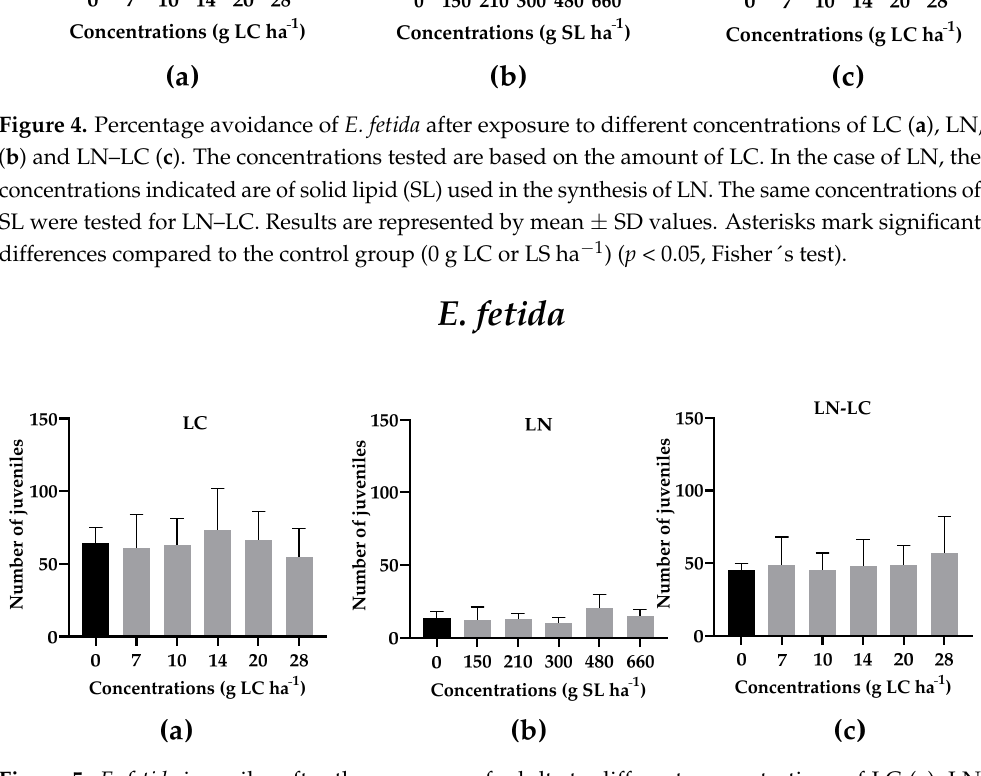
Figure 5. E. fetida juveniles after the exposure of adults to different concentrations of LC ( a ), LN ( b ) and LN–LC ( c ). The concentrations tested are based on the amount of LC. In the case of LN, the concentrations indicated are of solid lipid (SL) used in the synthesis of LN. The same concentrations of SL were tested for LN–LC. Results are represented by mean ± SD values ( p < 0.05, Dunnett). According to the results, the reproduction of F. candida was significantly affected only by the presence of LC ( p < 0.05; F (5, 24) = 5.903) at all the concentrations tested,